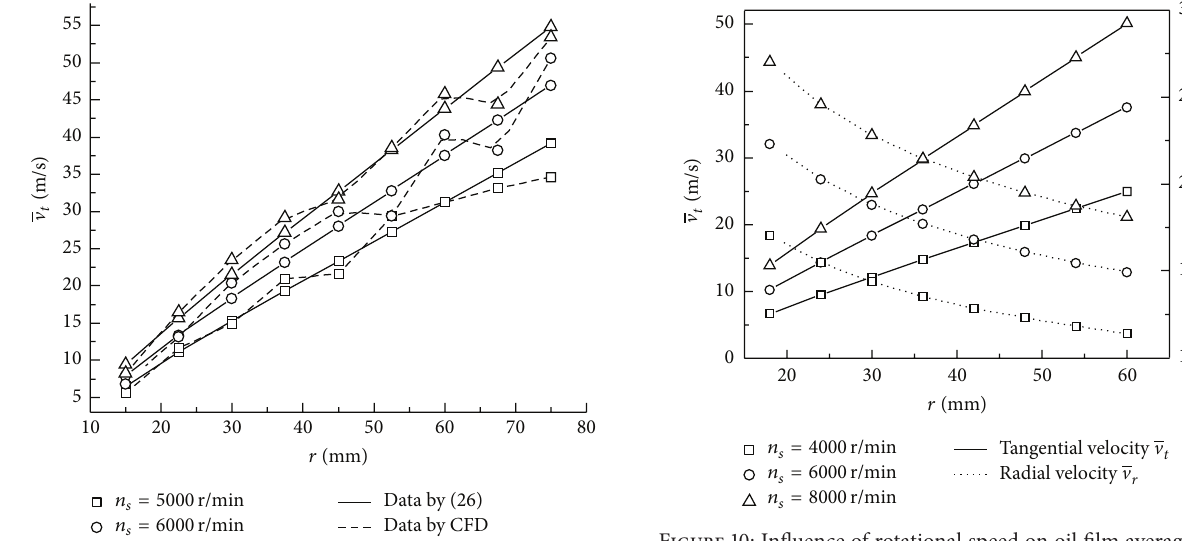
Figure 10: Influence of rotational speed on oil film average veloci- ties.